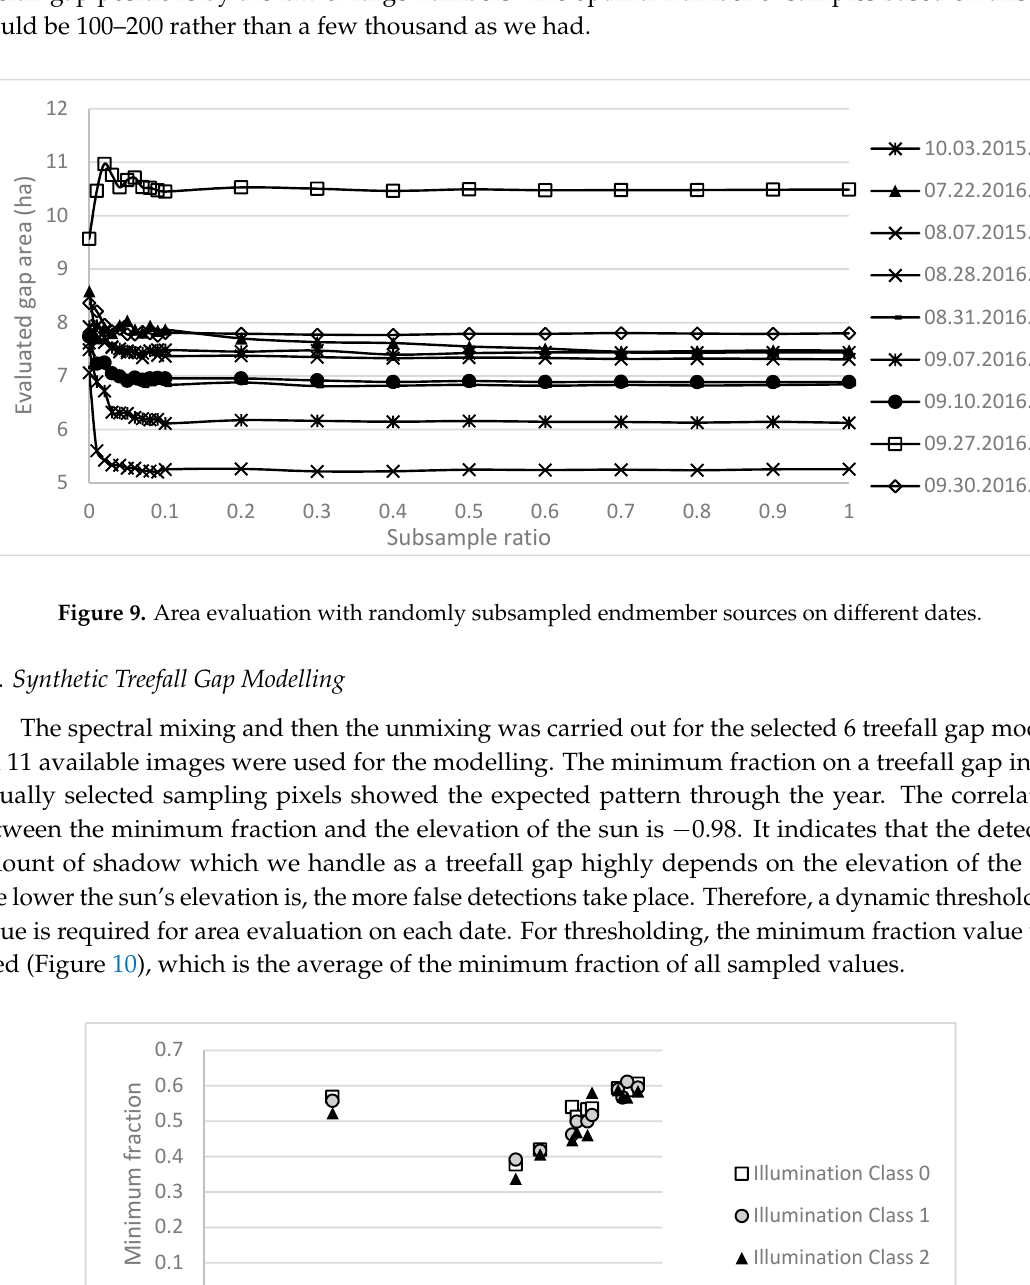
Table 4. Correlation matrices for all endmembers from different data types. R